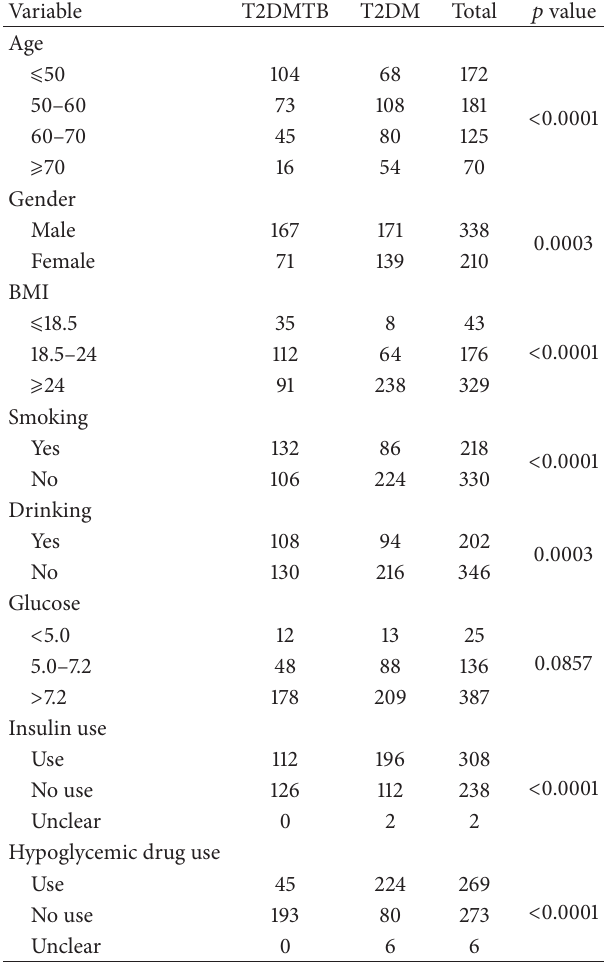
Table 1: Demographic characteristics of the subjects.